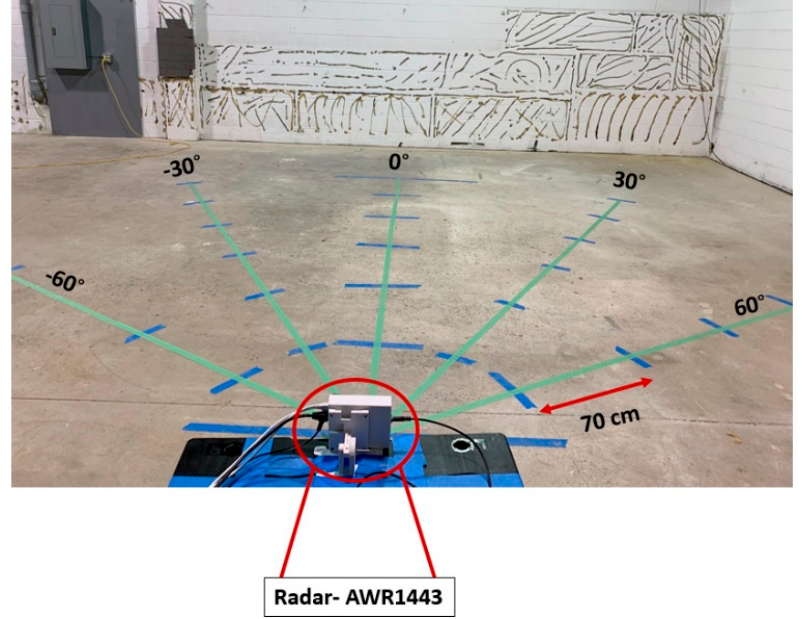
Figure 9. Experimental setup for gait assessment in a large space environment detection algorithm.